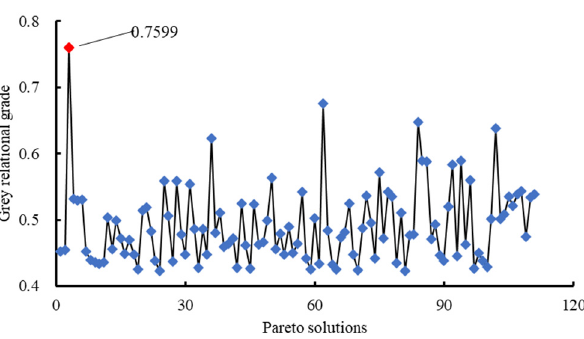
Table 7. Multi-objective reliability optimization results.